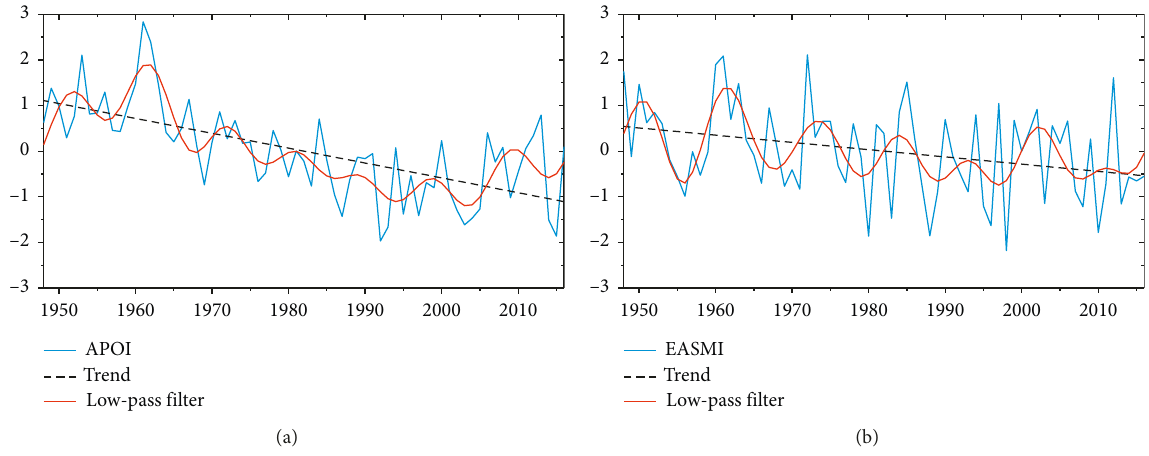
Figure 1: The interannual variation of the summer mean EASMI (a) and APOI (b) during 1948–2016.